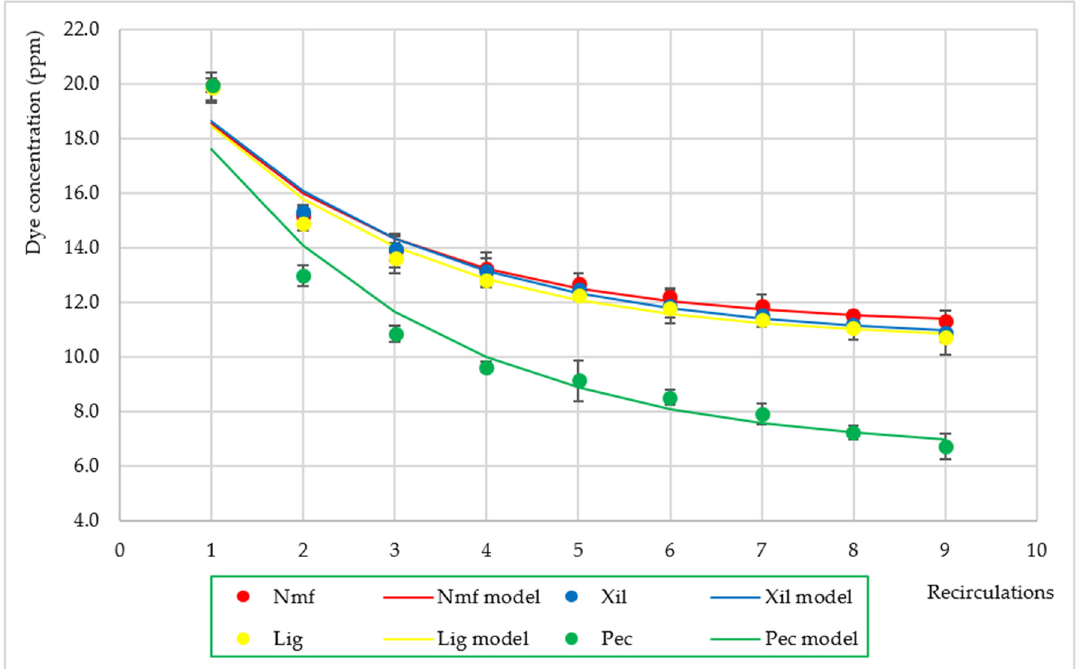
Figure 5. Variation in RB5 concentration using three enzymatic modifications of fique fiber: NMF: nonmodified fiber, Pec: fiber treated with pectinase, Xyl: fiber treated with xylanase, Lig: fiber treated with ligninase.